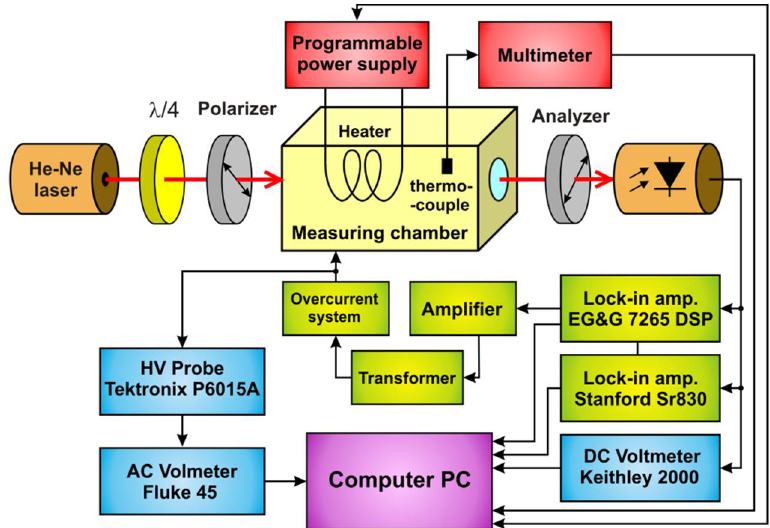
Figure 2. Diagram of the optical and electronic components employed in the measurements. The He-Ne laser Melles Griot 05-LPH-171, quarter-wave plate Melles Griot 02WRM001, and two Melles Griot 03FPI025 polaroid type polarizers were used. The laser used had linear polarization. An additional quarter-wave plate made it possible to obtain circular polarization and become independent of the laser position. Temperature was measured using a copper-constantan thermocouple.